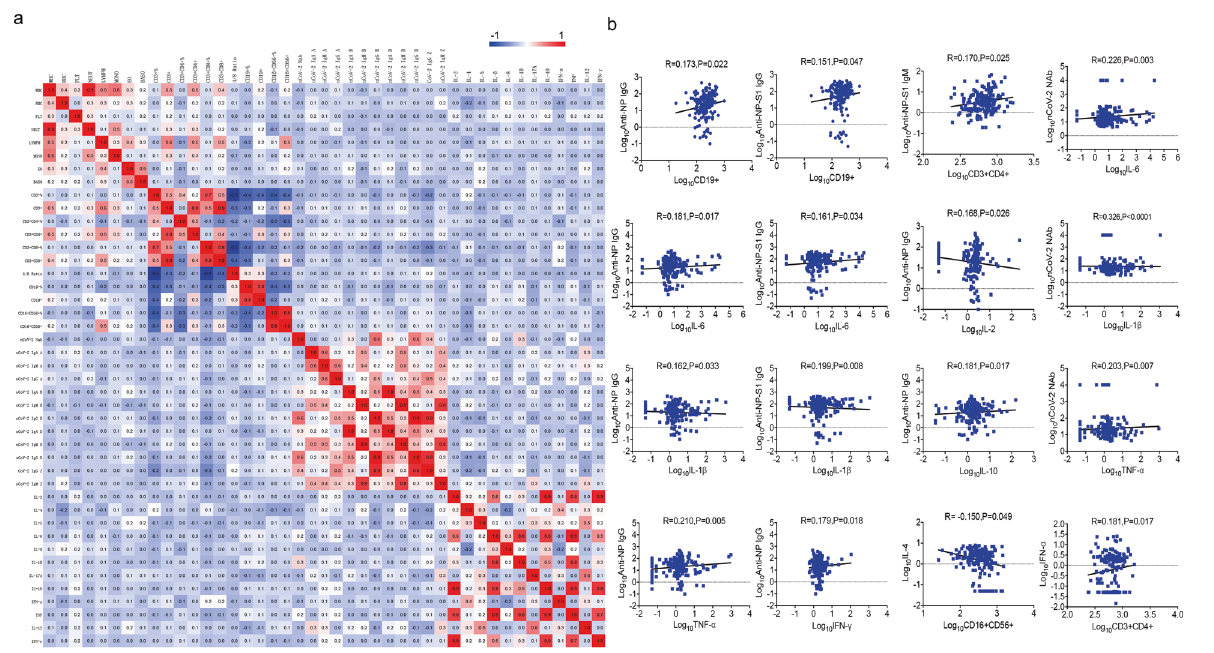
Fig. 3 Correlation of antibodies with lymphocyte subsets and cytokines in COVID-19 convalescent individuals. Pearson correlation between different antibodies and lymphocyte subsets and cytokines. a CorHeatmap was used to color these correlations: blue indicates negative correlations, red indicates positive correlations, and the color intensity indicates the strength of the correlation. b Scatter diagrams were used to describe the